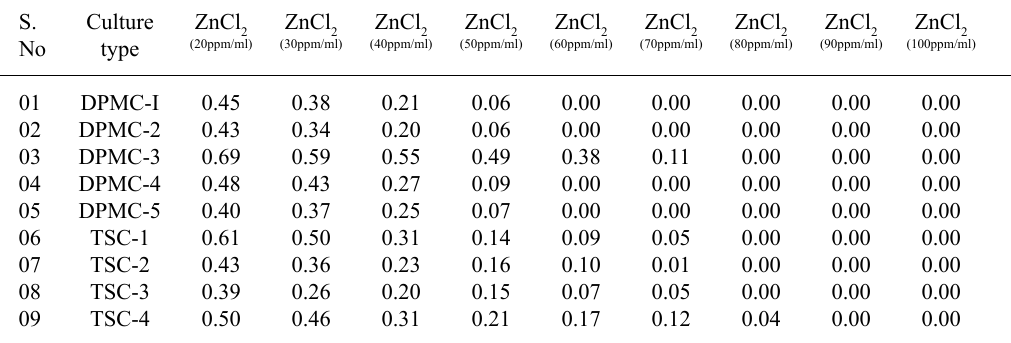
Fig. 4. Effect of Zinc on bacterial growth (OD at table 4. Effect of Zinc on bacterial growth (OD at 620nm)